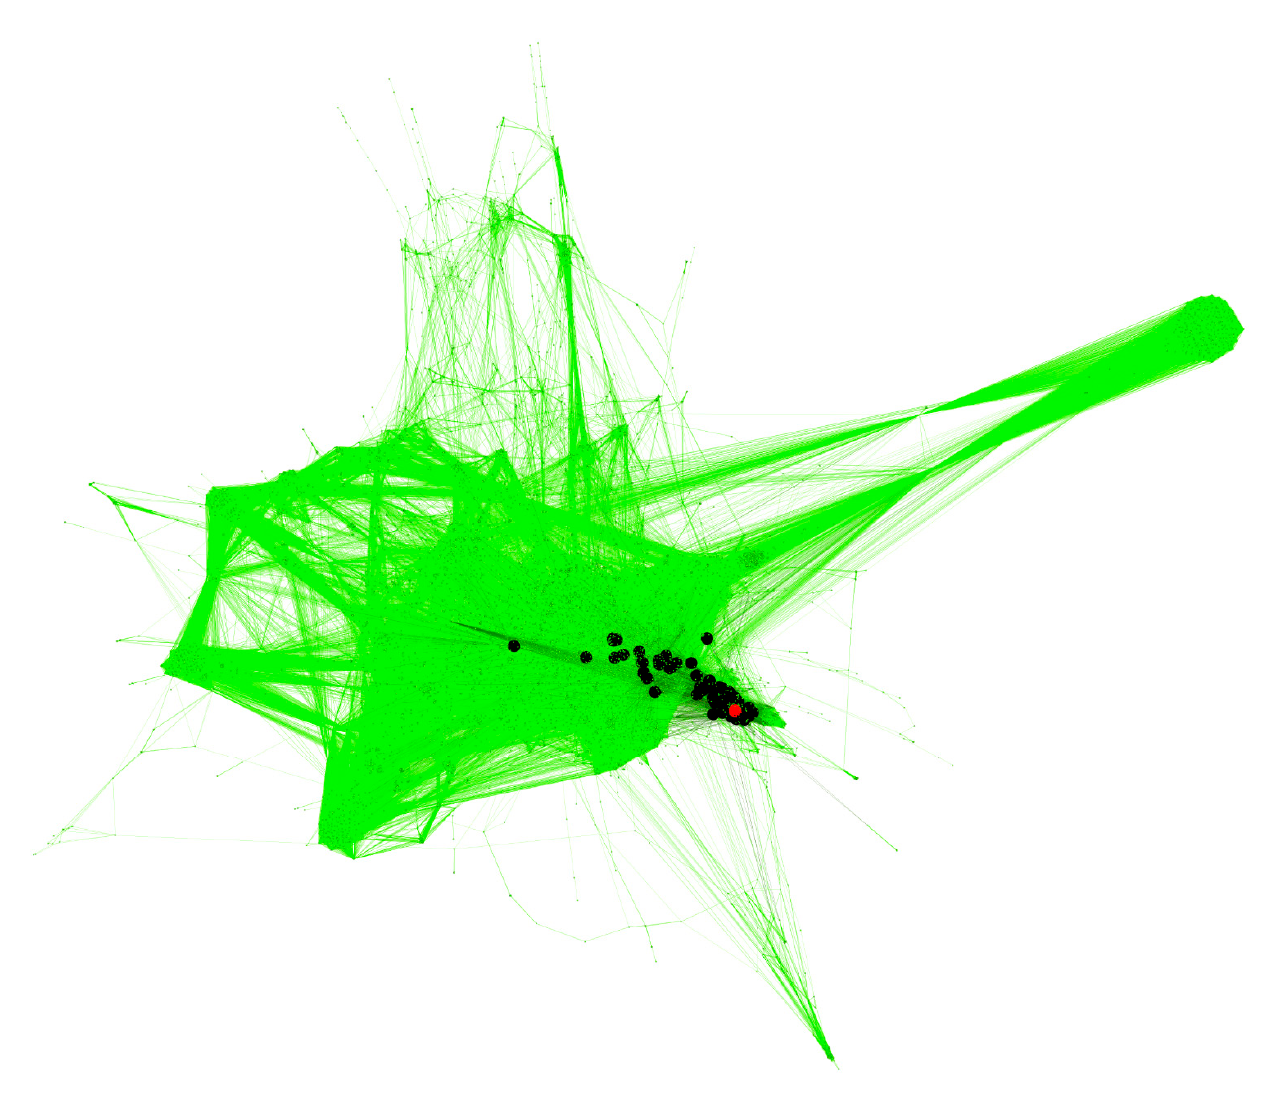
Figure 2. Human interactome model. Genes (gene products) are nodes and protein-protein interactions are edges of the graph. Black dots represent gene products involved in the FREM2 pathway corresponding to PAL2, and the red dot denotes the FREM2 gene product.